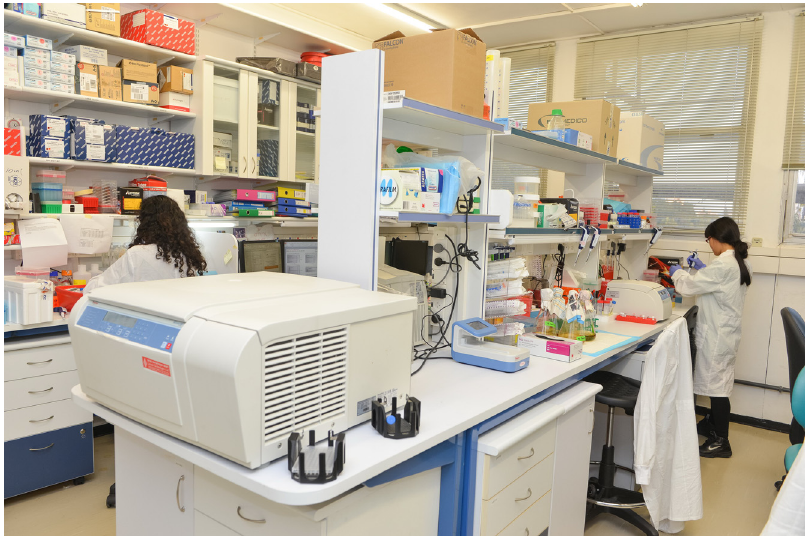
Figure 2: A laboratory in the Weizmann